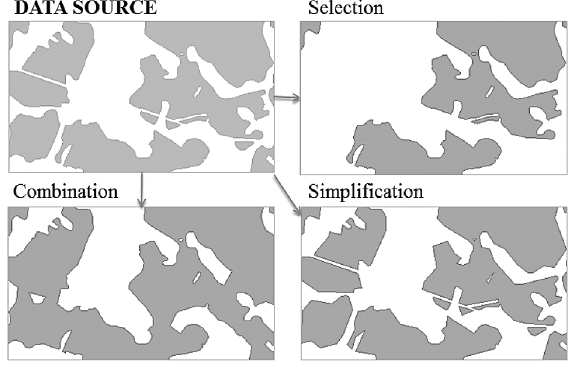
Fig. 2. Spatial data modification after generalisation Fig. 3. Concept of generalisation of reference